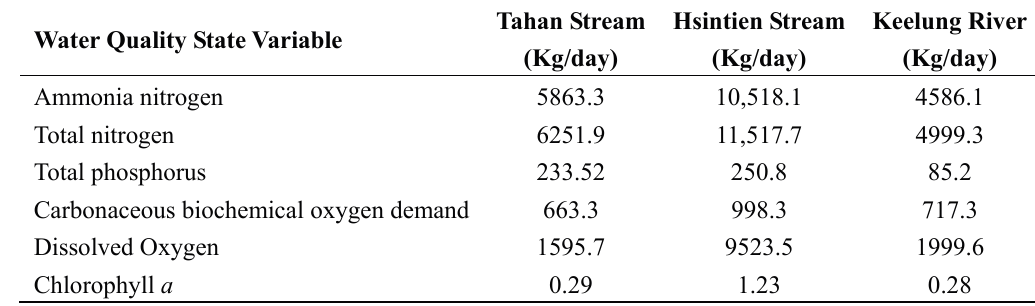
flow condition. 75